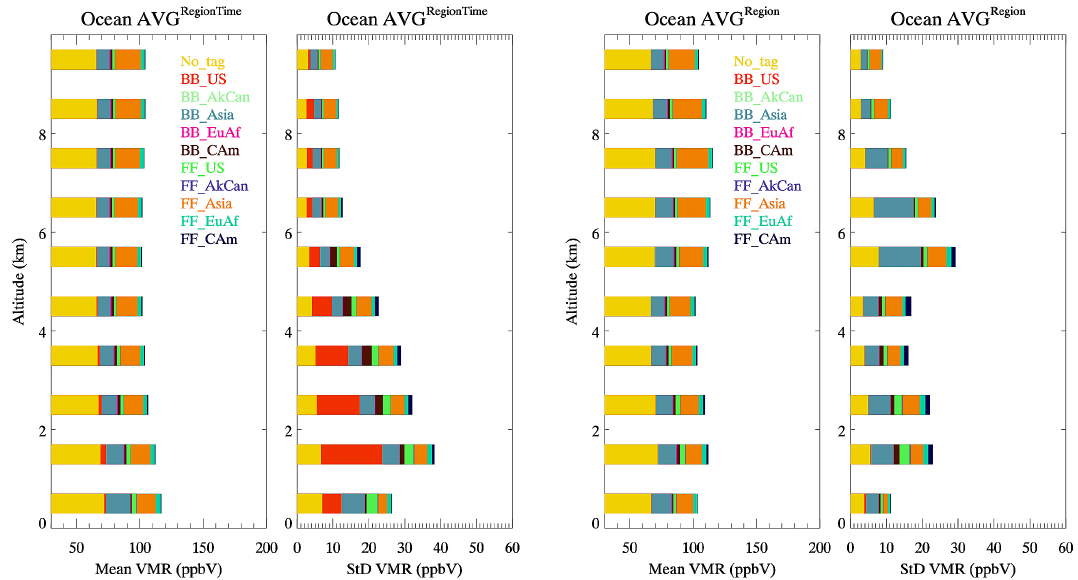
Fig. 4. Modeled CO Tracer concentrations (Mean and STD (ppbV)) for different CO Source types and temporal averages. Results for AVGRegionTime (left-hand side) and AVGRegion (right-hand side). (BB=Biomass burning; FF=Fossil Fuel). The contributions in (%) per 1km high altitude bin and tracer type are given as numbers above each bar. See Table 1 for a summary of 2–8km